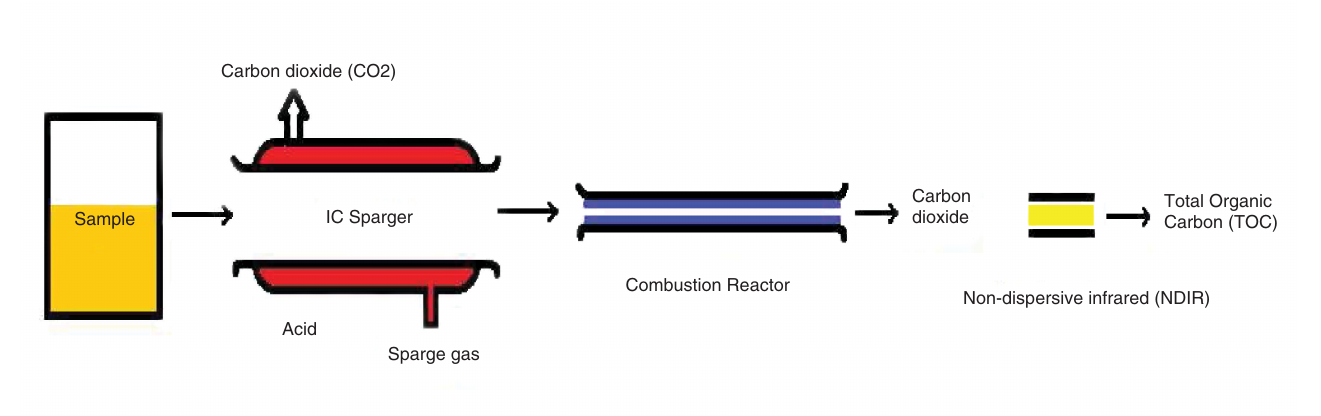
Figure 1. Principle of TOC